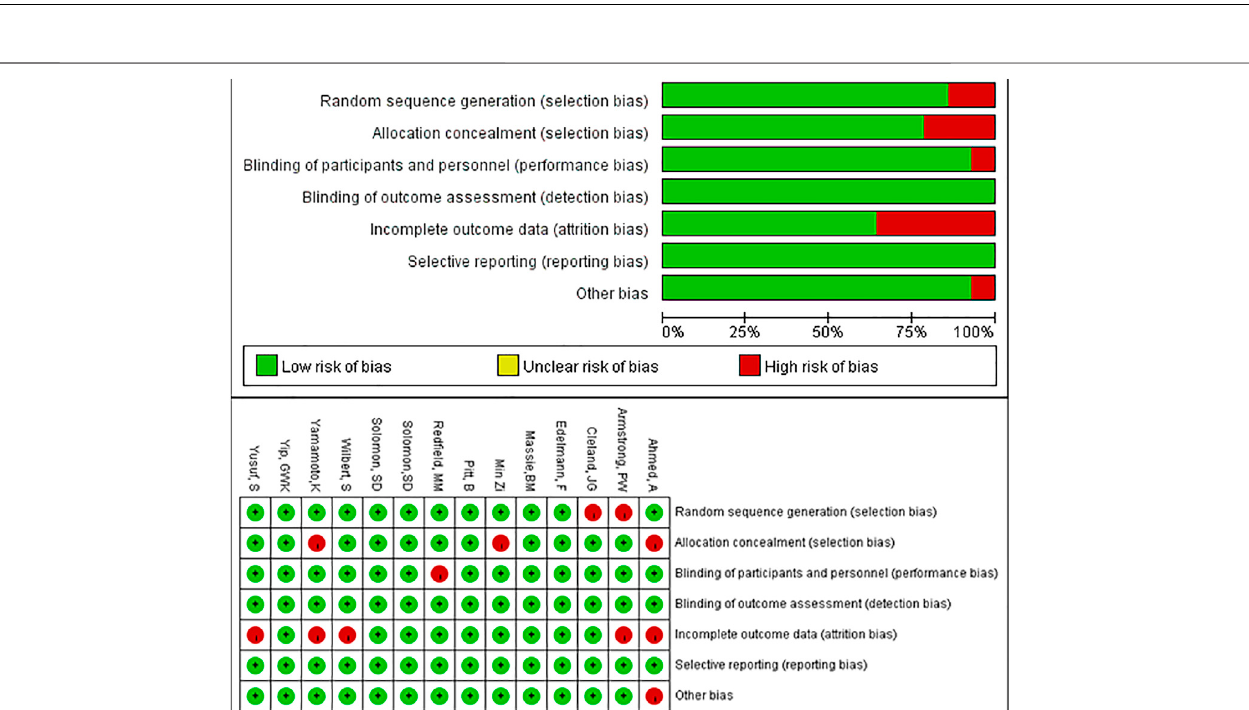
FIGURE 4 | Heart failure hospitalization (secondary outcome): Forest plot (estimates as hazard ratio) -All trials.